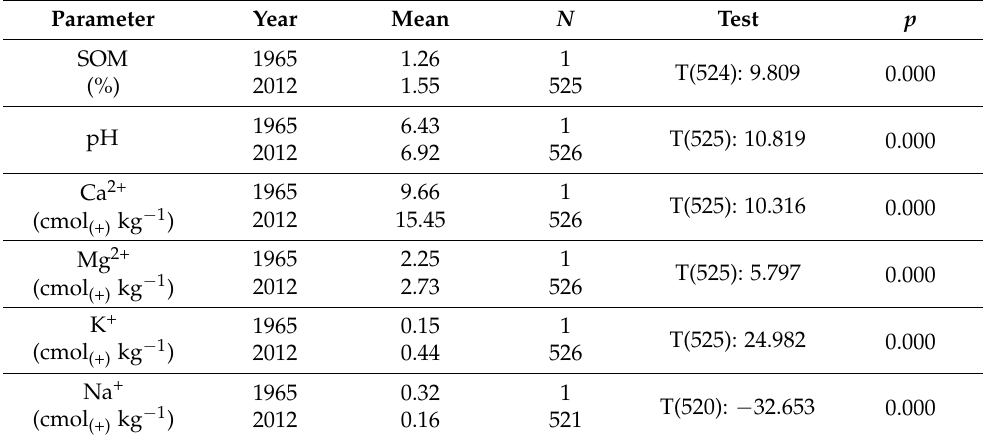
Table 8. Long-term evolution (1965 to 2012) of selected soil parameters in rain-fed soils.